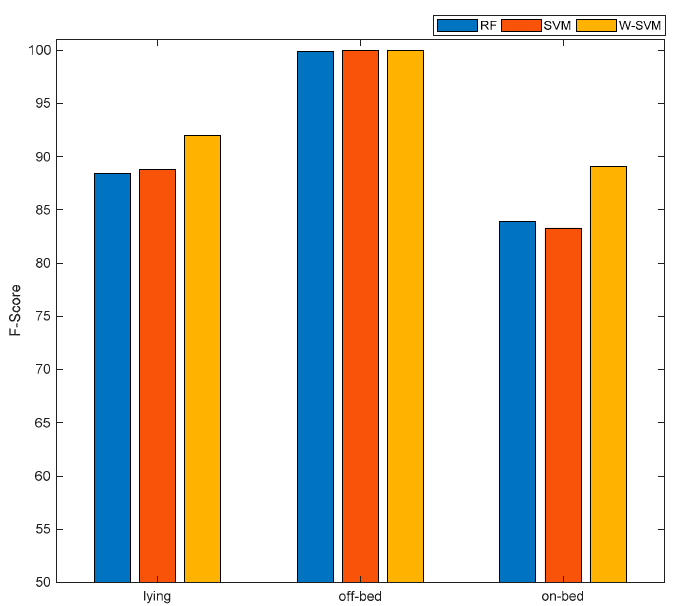
Figure 5. Performance analysis of Smartphone data on different Activities of Daily Livings (ADLs) using various classifiers. Table 5. Computational complexity across different classifiers for four traces received at a time.